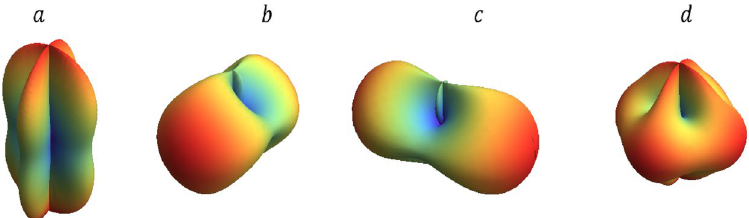
Figure 3. Assuming polarization angle ψ = 0 , the response of the interferometer to (+) polarization on three planes are shown respectively, X – Y plane ( a ), Y – Z plane ( b ), X – Z plane ( c ), and the total response to (+) polarization ( d ). Color indicates increasing sensitivity from indigo to